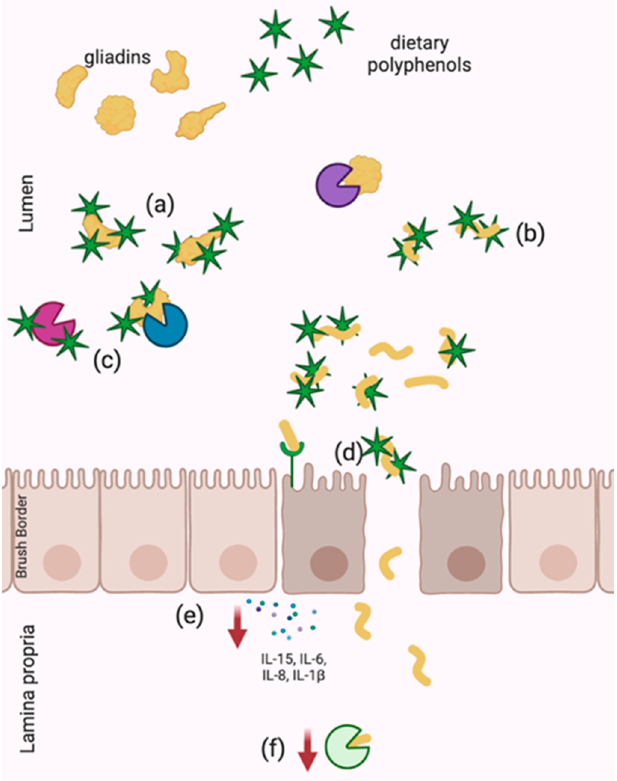
Figure 2. Demonstrated mechanisms of celiac disease pathogenesis disruption by dietary polyphenols including ( a ) physical sequestration of native gliadins and ( b ) hydrolyzed gliadins, ( c ) digestive enzyme inhibition, ( d ) improved barrier integrity and decreased paracellular transport of gliadins, ( e ) anti-inflammatory activity and ( f ) TG2 downregulation. Arrows represent decreased expression.